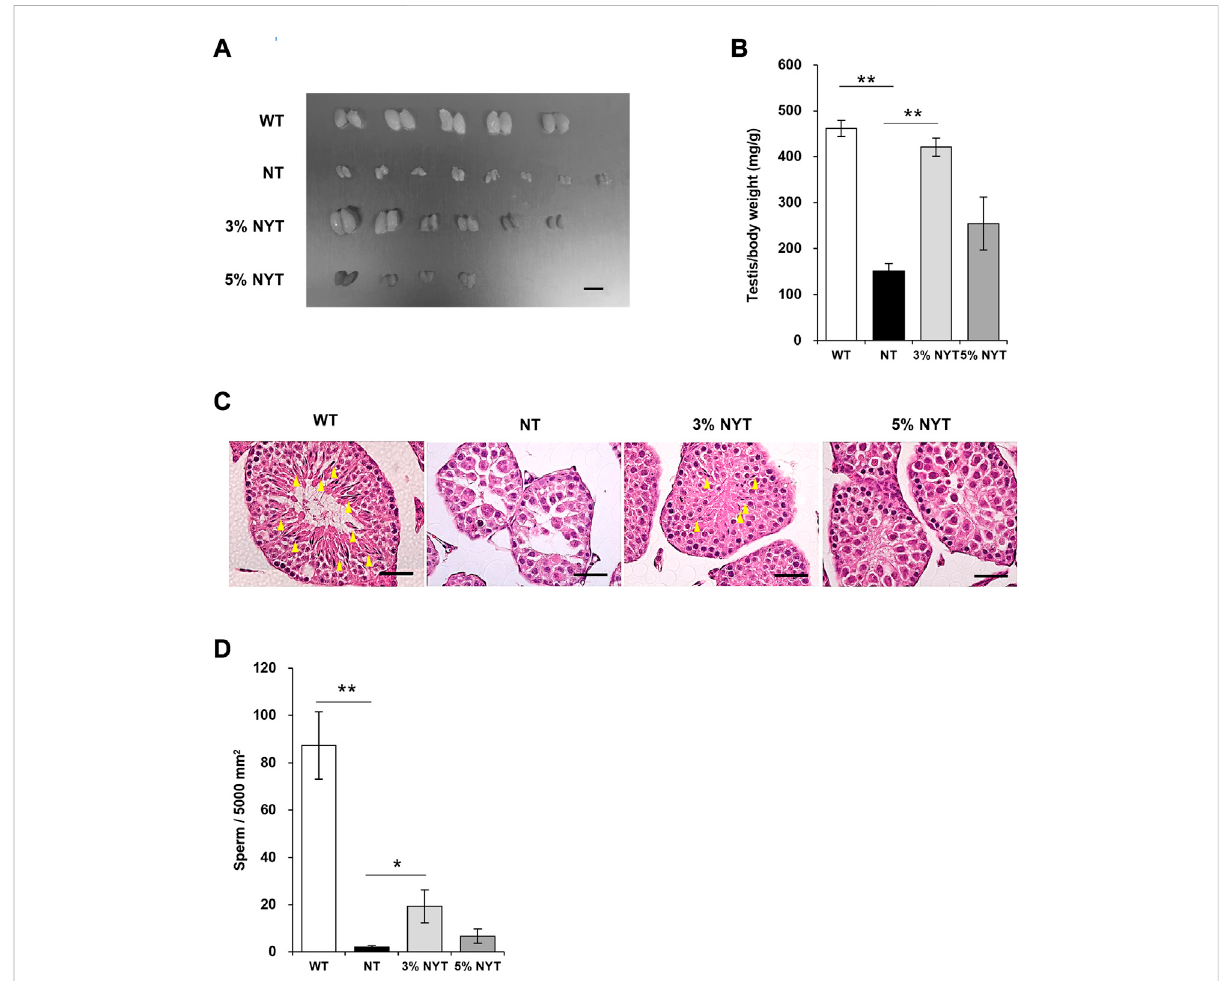
FIGURE 4 EffectofNYTonsuppressionoftesticulargrowthandspermatogenesiswithprematureaging.ThedissectedTestistissueimages (A) on59 days old and its wet weights (B) are shown, scale bar indicated 8 mm (A) . Histological staining (hematoxylin/eosin) of testicular tissue are shown in (C) , scalebarindicated40 μ m.Yellowarrowsindicatespermatozoaintheseminiferoustubules.Thenumberofspermatozoaintheseminiferoustubules of the testicular cross section was counted and are shown in (D) . Data are indicated as mean and SEM values. Signi fi cant differences are presented on histograms: [* p < 0.05, ** p < 0.01, Steel test, WT ( n = 5), NT (8), 3%NYT (6), 5%NYT